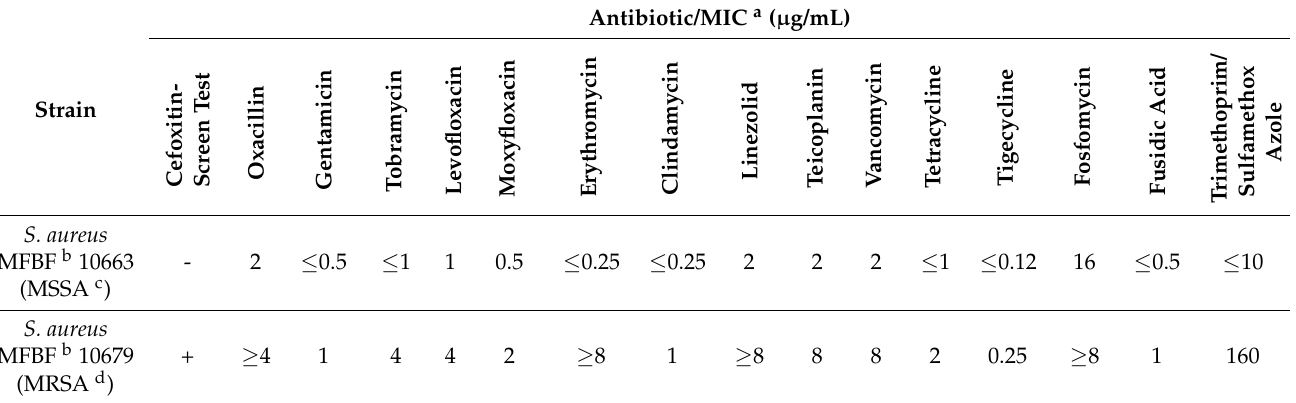
Table 1. Susceptibility of S. aureus clinical isolates used in the study determined with VITEK ® 2 automated susceptibility testing